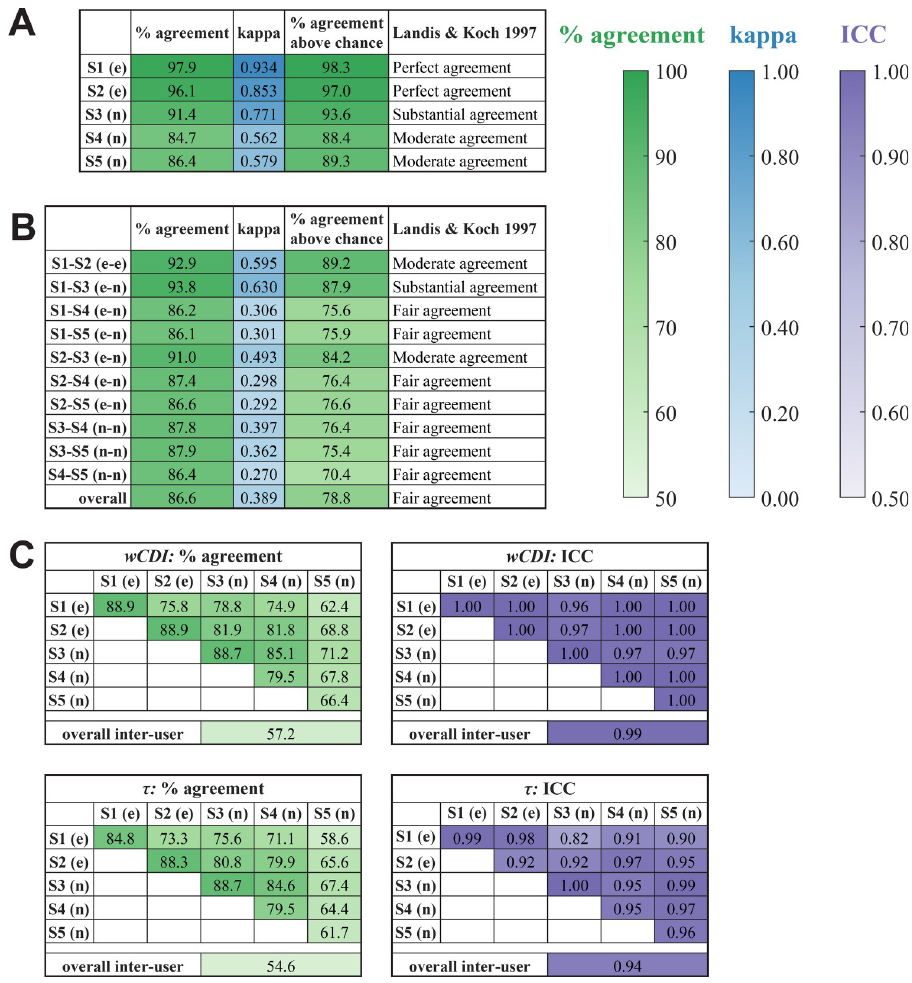
Fig 4. Intra- and inter-user reliability analysis of the mechano-NPS data processing pipeline. Reliability analysis results obtained from the data presented in Fig 3 (e) and (n) designate experienced and novice users, respectively. Number of cells found in each observation ranged from 49–82. Intra- (A) and inter-user (B) agreement analysis examines the consistency of users’ decisions to save or discard cell measurements. “% agreement” quantifies the percentage of potential cell events in which all observations agreed on whether to save or discard the event. Fleiss’s kappa analysis was also performed to determine the “kappa” value as well as the “% agreement above chance.” “Landis & Koch 1997” indicates the interpretation of the kappa value according to [17]. For all comparisons, Fleiss’s kappa analysis rejected the null hypothesis that the observed agreement was accidental ( p < 10 − 10 ). (C) Intra- and inter-user concordance analysis examines the consistency of the observed quantitative cell phenotypes for each of the two phenotype variables: wCDI and recovery time constant τ . “% agreement” quantifies the percentage of cell events in which all observations found the same phenotype value, within tolerance. We also calculated the intra-class correlation (ICC) value, which quantifies the degree of correlation among the observations. For all comparisons, ICC analysis rejected that the null hypothesis that ICC = 0 ( p < 10 − 10